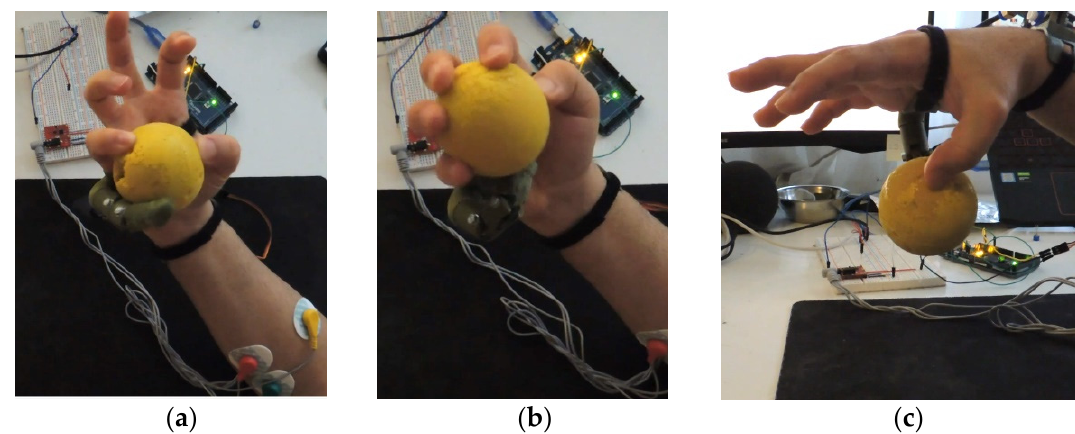
Figure 9. Screenshots from animation-small-finger.avi (Supplementary Material): ( a ) holding a soft ball, ( b ) pressing it against the side of the third thumb, and ( c ) holding it between real and third thumb.